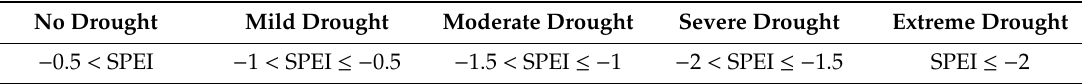
Table 1. Drought classification, based on the SPEI